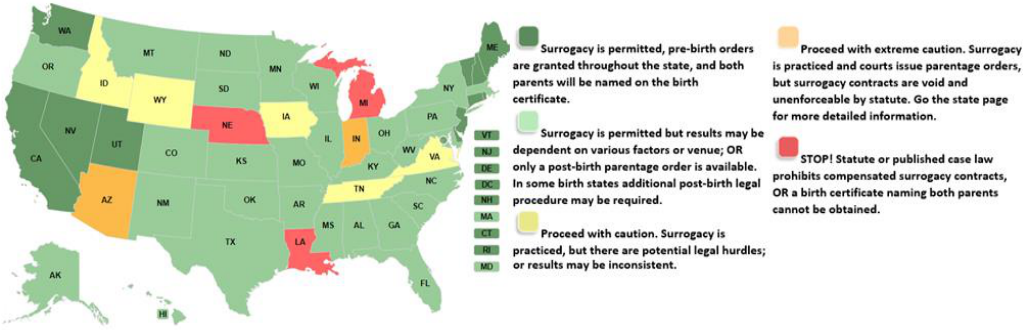
Figure 2: US Surrogacy Map. Retrieved and adapted from https://www.creativefamilyconnections.com/us-